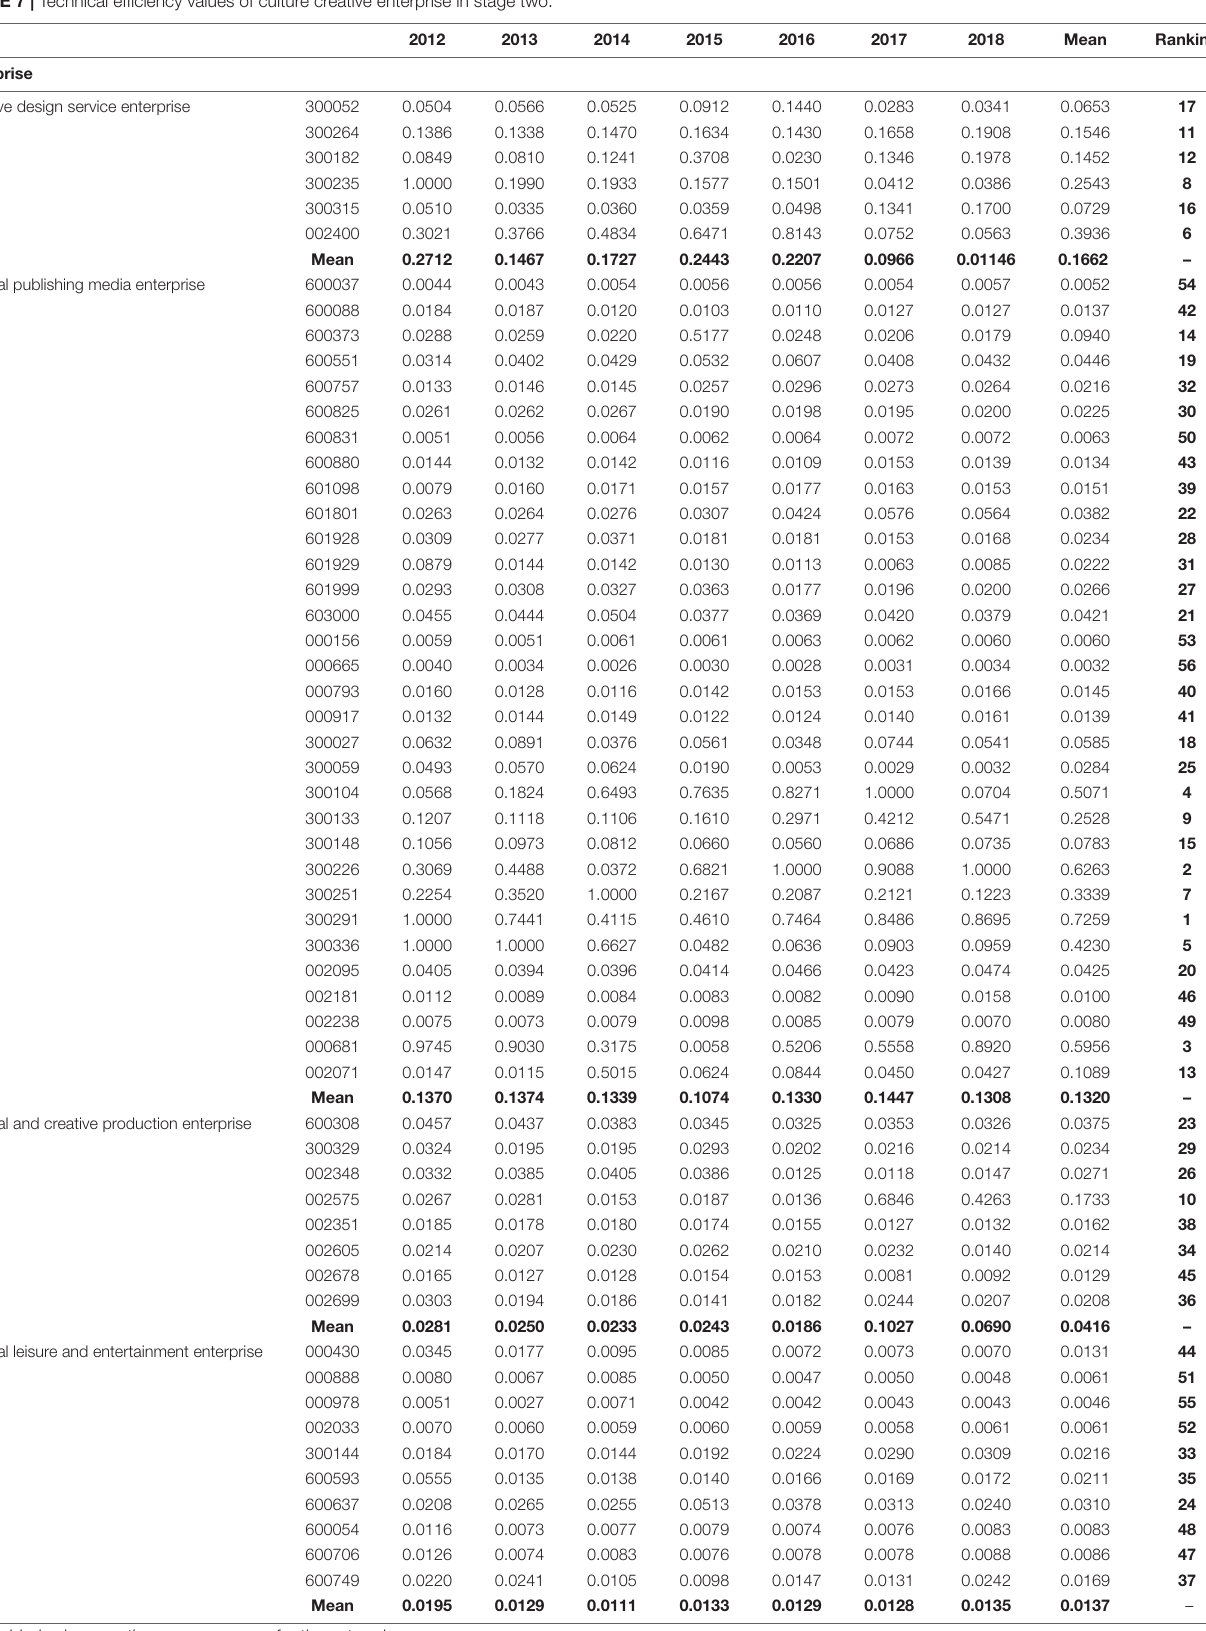
TABLE 7 | Technical efficiency values of culture creative enterprise in stage